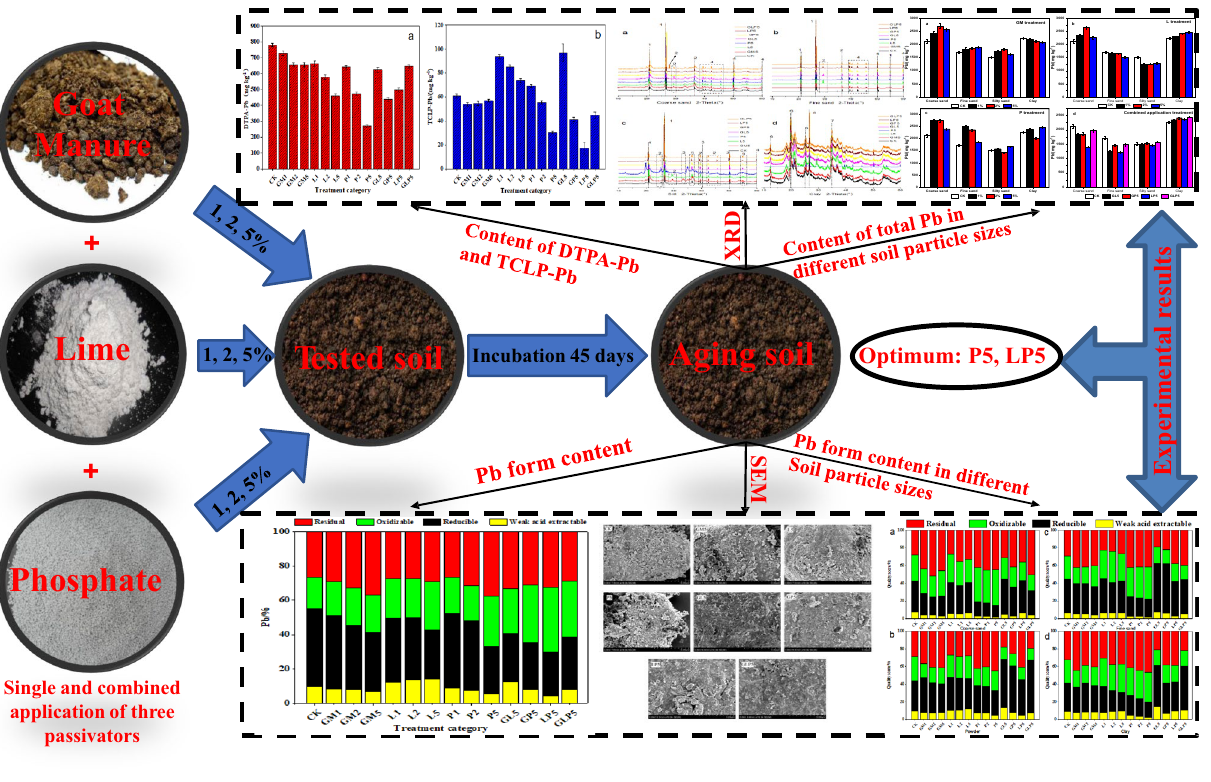
Figure 1. Overview of the main content of the